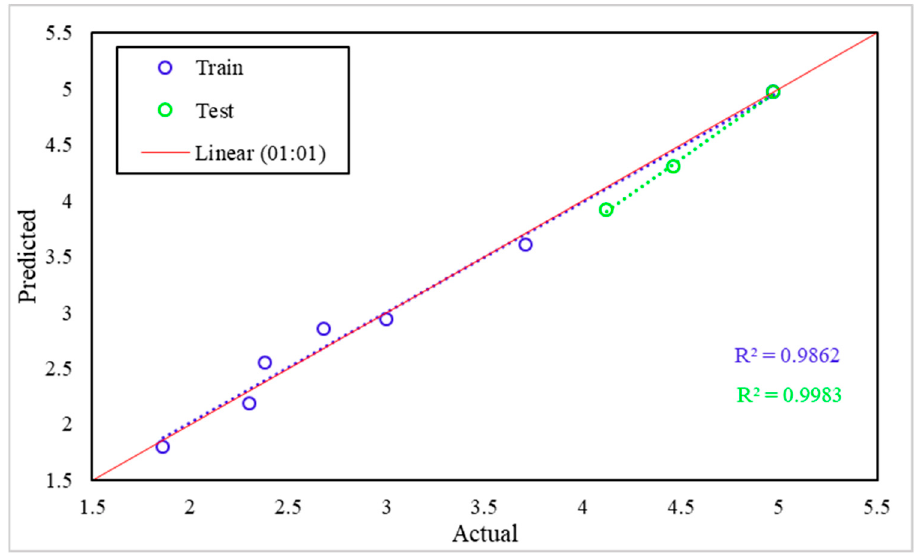
Figure 23. Tensile strength scatter plot between actual and predicted values.